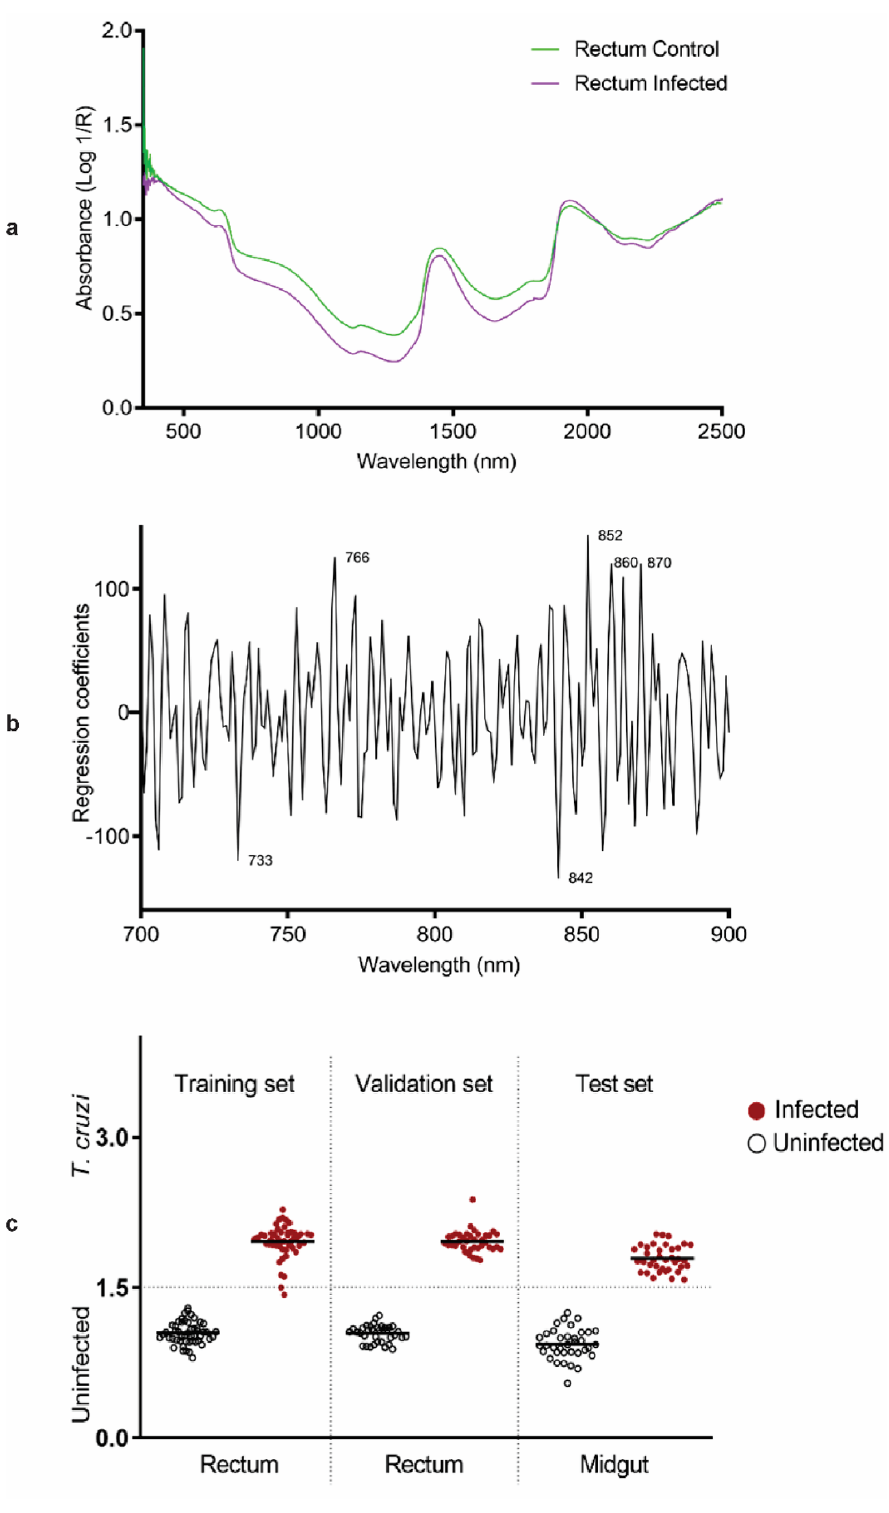
Figure 2. Summary of NIRS data regarding T. infestans rectum. ( a ) Average NIR spectra in the 350- to 2500-nm region from T. cruzi -infected and uninfected triatomine recta. ( b ) Regression coefficients using six factors in the PLS model based on the NIR spectra in the 700–900 nm region for differentiating T. cruzi -infected from uninfected samples. ( c ) NIRS differentiation of T. cruzi - infected and uninfected recta, using leave-one-out cross-validation analysis (training set) and samples that were used to validate the model (validation set) and samples and spectra from the midgut that were used to test the model (test set). Each circle represents an individual insect; infection status confirmed by PCR is indicated by red (infected) or empty (uninfected) circles. The lines indicate the mean prediction value for each group. The vertical axis indicates infection status as predicted by NIRS and was drawn by plotting the actual constituent values (1 = uninfected and 2 = infected), with the dotted line indicating the classification cut off point (1.5). Infected triatomines shown below the dotted line and uninfected triatomines shown above the dotted line were falsely